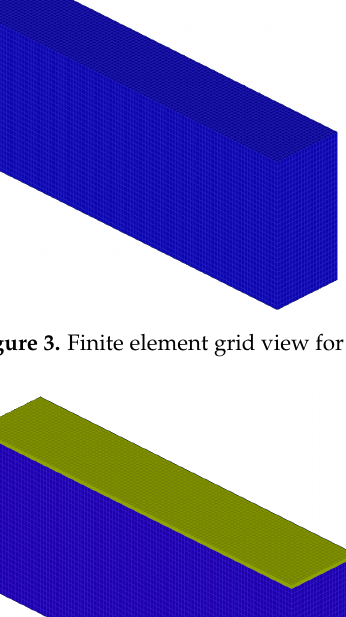
Figure 5. The results of the V05 static analysis (polymer concrete No. 15).